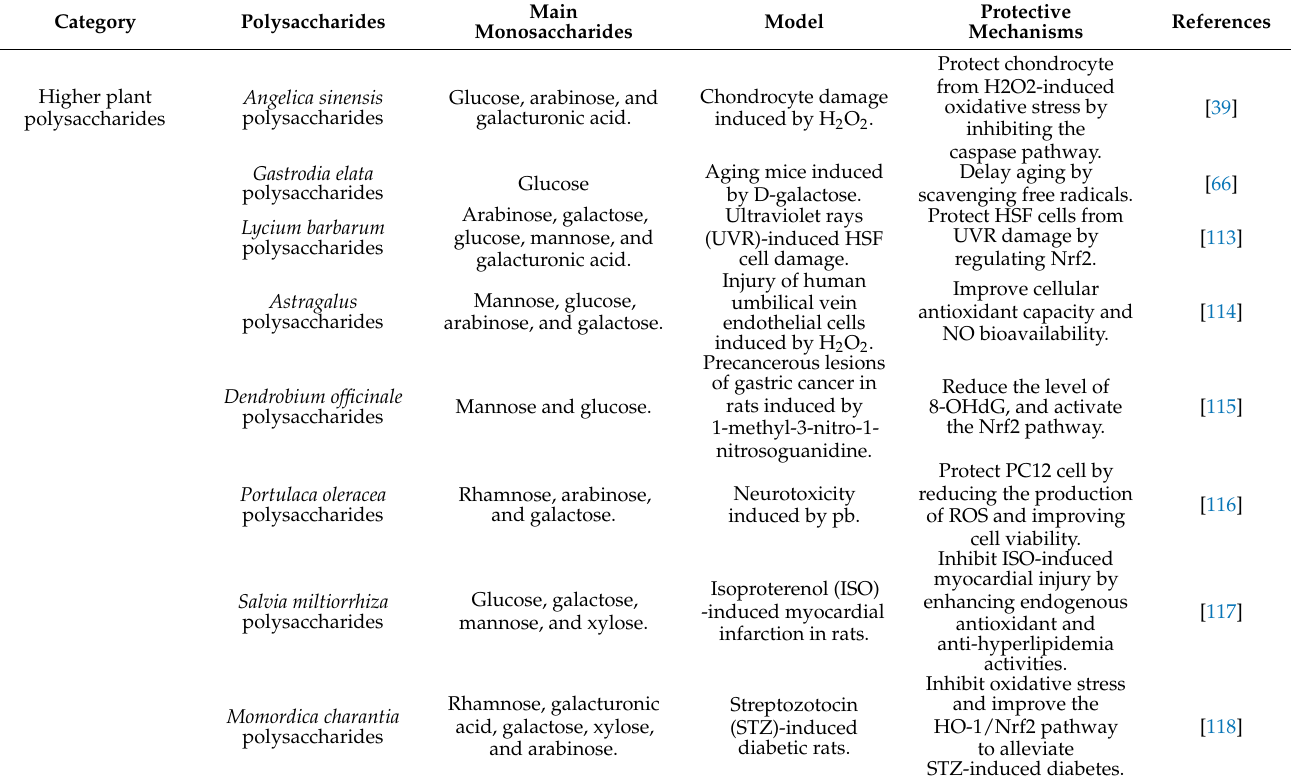
Table 1. Natural polysaccharides and their antioxidant